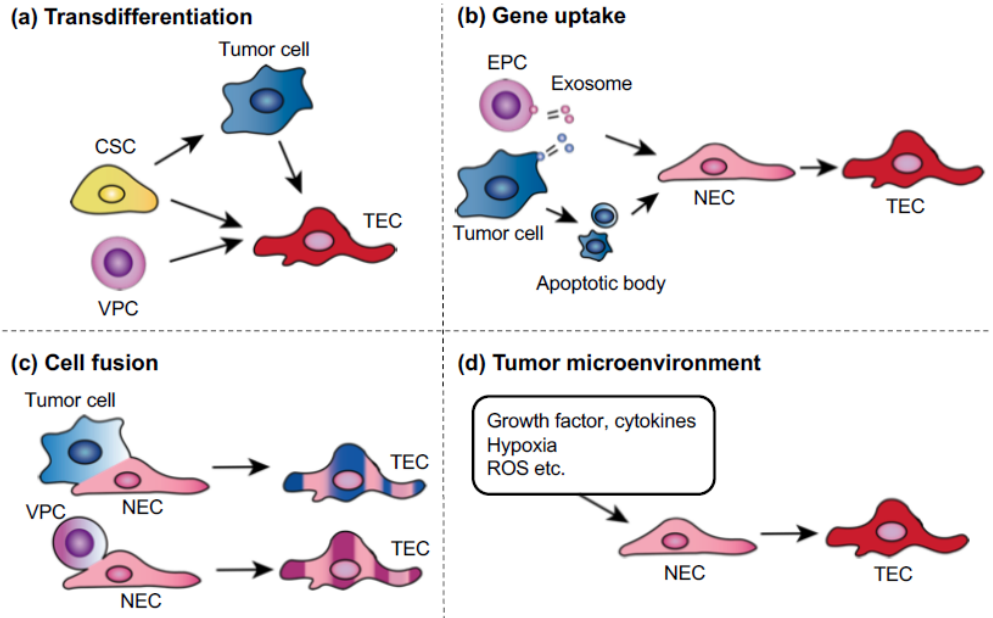
Figure 3. Possible mechanisms of tumor endothelial cells (TEC) abnormalities. ( a ) Transdifferentiation: tumor cells, cancer stem cells, or vascular progenitor cells (VPCs) might transdifferentiate into TECs. ( b ) Uptake of oncogenes or gene transfer: ECs can take up human tumor oncogenes by phagocytosis of apoptotic bodies or exosomes, which are released from either endothelial progenitor cells or tumor cells. ( c ) Cell fusion: malignant tumor cells can fuse with normal endothelial cells (NECs) or circulating VPCs. ( d ) Tumor microenvironment: growth factors or cytokines in the tumor microenvironment might be factors that cause genetic instability. Hypoxia in tumors is known to cause genetic changes, such as the upregulation of survival factors, not only in tumor cells.